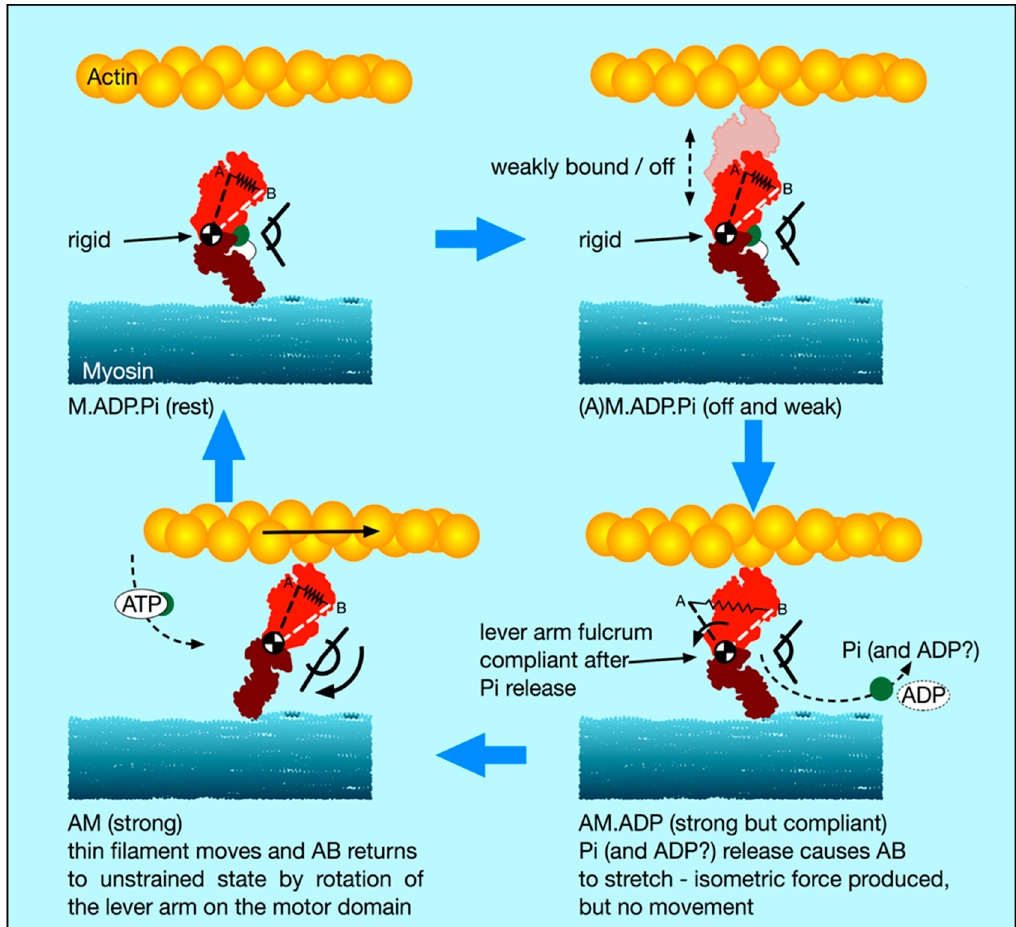
Figure 8. The new cross-bridge scenario: The spring AB represents the elastic state of the head. Top left: relaxed muscle with hydrolysis products ADP and Pi on myosin (M.ADP.Pi) has relatively rigid, but bent, myosin heads, with the fulcrum (converter domain) between the motor domain and lever arm relatively stiff. On activation (top right; (A)M.ADP.Pi), the heads go into a very rapid equilibrium weak binding state on actin in which the heads are still relatively rigid and these would provide high stiffness if the sarcomere is stretched or released fast enough. Strong binding to AM.ADP.Pi and release of Pi (bottom right) causes an associated release of the converter/ lever arm to a relatively elastic, lower stiffness, state. The new head shape wants to be relatively straight as in the bottom left panel (rigor-like), but the lever arm cannot move if the myosin and actin filaments cannot move (e.g., under a high load or isometric). The lever arm remains in its original position, but it now exerts force (indicated here by the stretched spring, AB). If the filaments are free to move, then the lever arm swings on the actin-attached motor domain (bottom left) until at the end of its stroke it exerts zero force; AB is back to its original shorter length and the head is relatively straight. Rapid binding of another ATP to give AM.ATP (flexible) releases the head from actin. Hydrolysis of ATP to ADP and Pi then occurs, and the heads revert to the rigid, but bent, M.ADP.Pi state (top left).